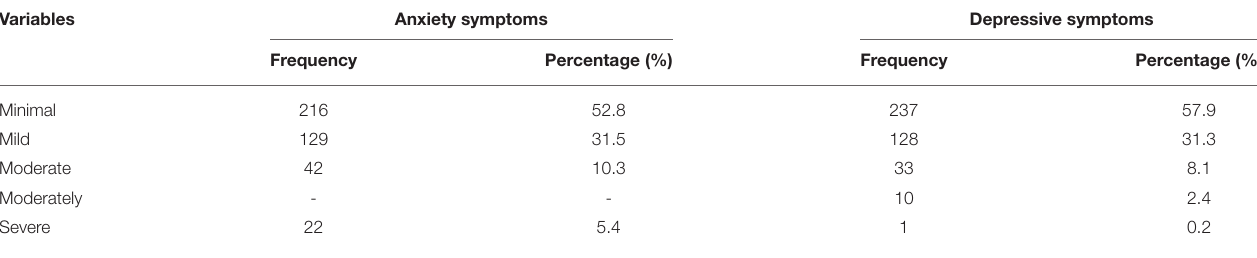
TABLE 5 | The rate of different severities of anxiety and depressive